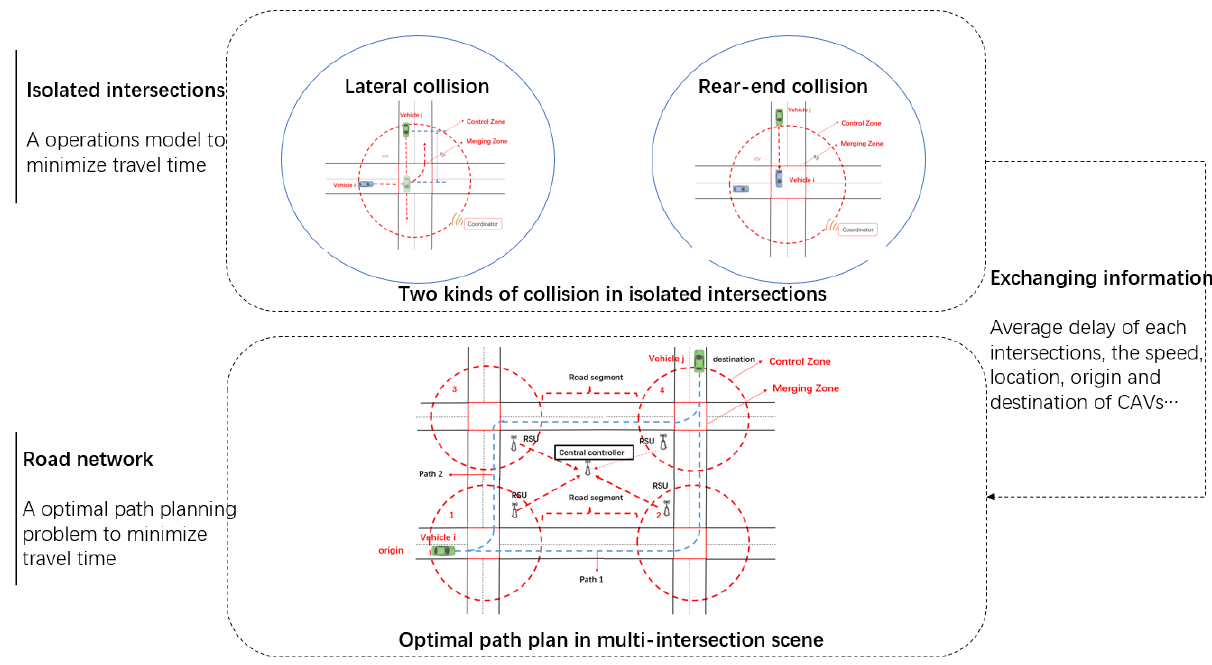
Figure 4. Illustration of exchanging information between RSUs and the central controller at an isolated intersection. Numbers 1–4 represent the intersection number.